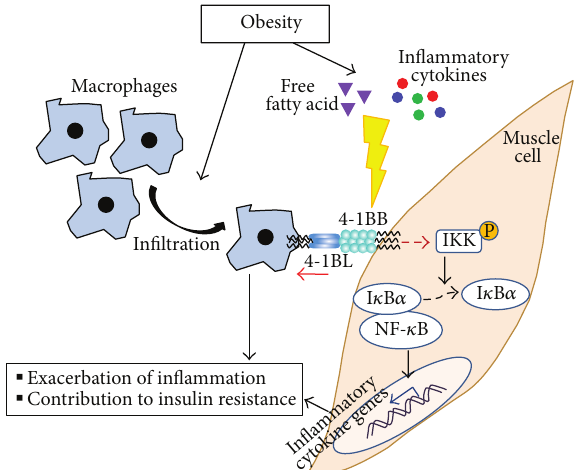
Figure 5: A schematic representation for the effect of 4-1BB/4- 1BBL interaction on skeletal muscle inflammation. Obesity induces upregulation of 4-1BB on skeletal muscle cells, which interacts with its ligand 4-1BBL expressed on infiltrated macrophages. This inter- action triggers bidirectional inflammatory signaling into both cells, leading to exacerbation of inflammatory responses and metabolic dysfunction in skeletal